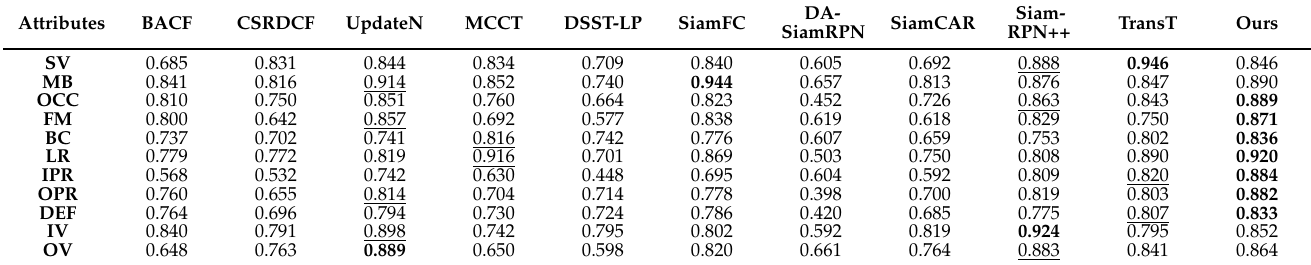
Table 5. Comparison with the other trackers in terms of precision rate on IMEC25.